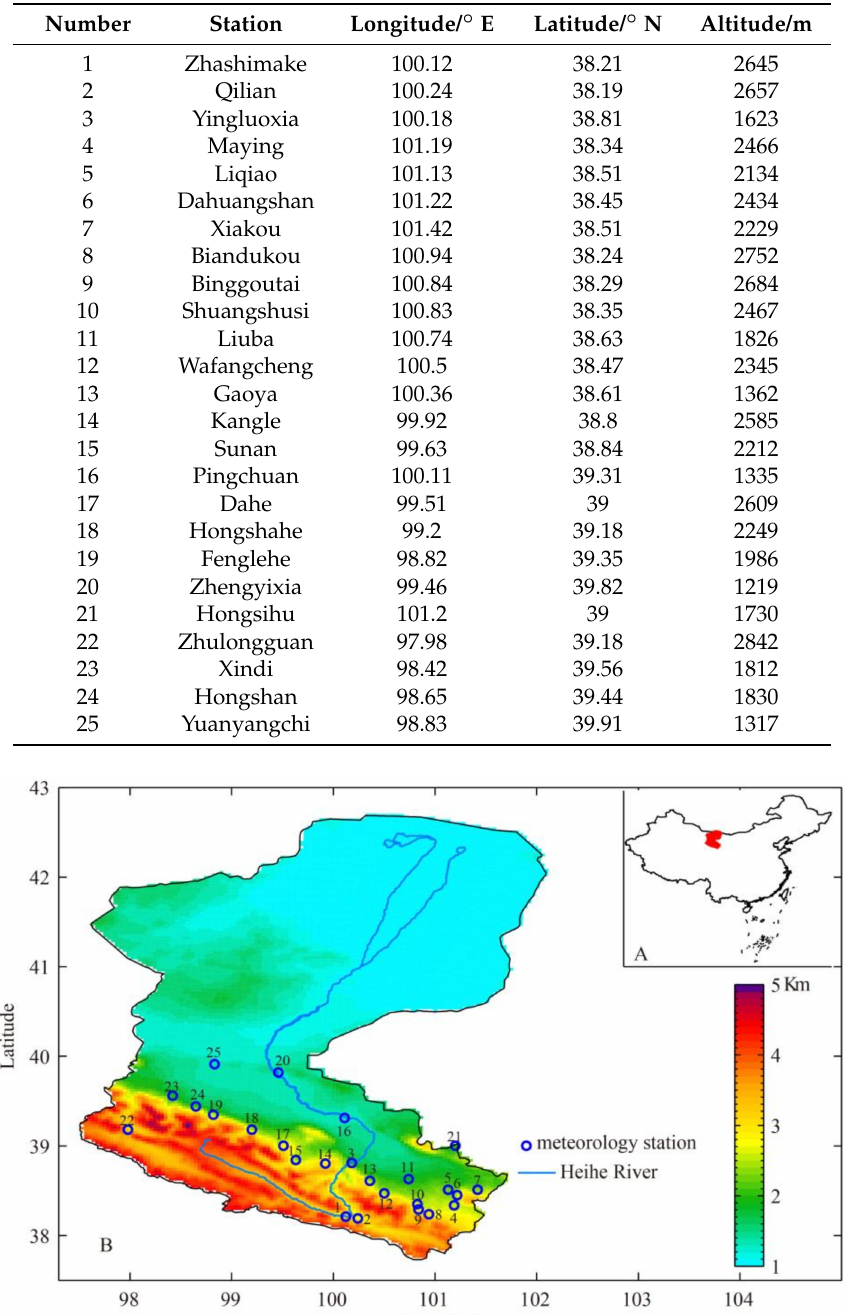
Table 1. Meteorological stations used in this study.